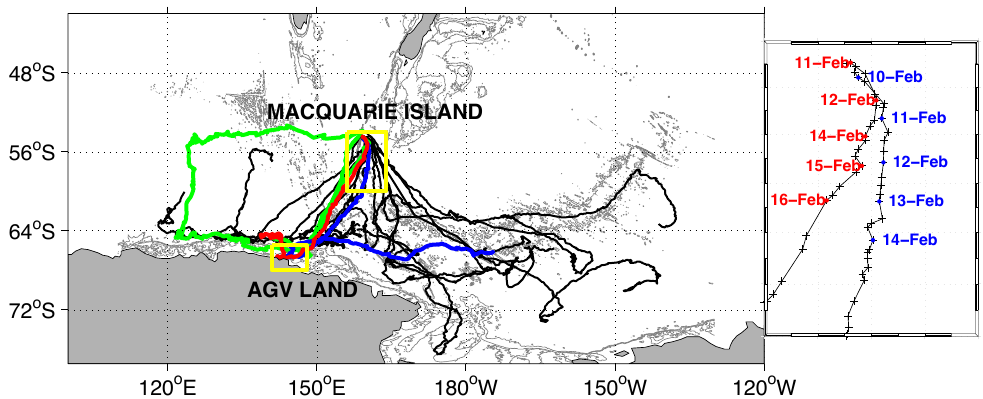
Fig. 1. Southern elephant seal tracks from IMOS in 2010 (black lines). Specific seals that sampled the Ad´elie and George V Land continental shelf: seals I1 and I2 (blue and red lines, respectively), and SEaOS seals (2005) S1 and S2 (green lines). Inset: Change in direction of seals I1 and I2 (blue and red, respectively) from SSE to SSW after leaving Macquarie Island (start) in February 2010, hypothesised to be in response to the calving of the Mertz Glacier Tongue